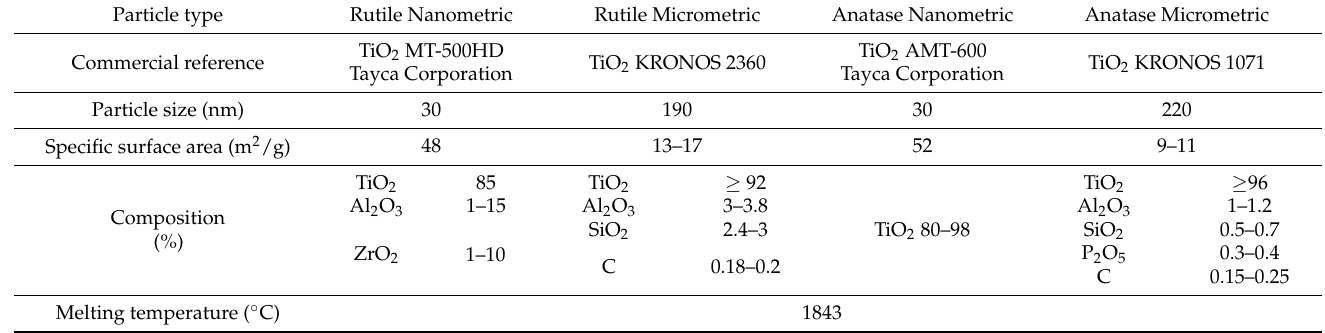
Table 2. TiO 2 particle characteristics provided by the manufacturer.